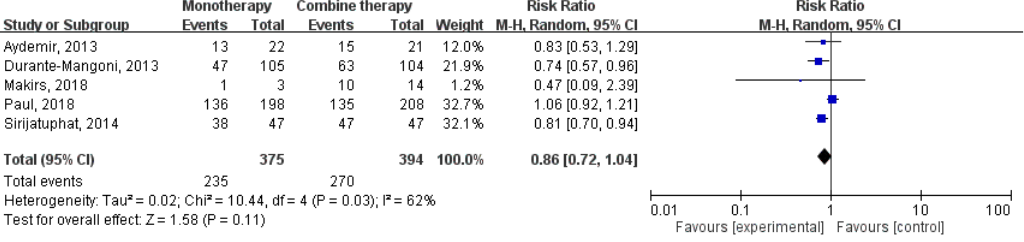
Figure 6. Colistin monotherapy versus colistin-based combination therapy, microbiologic response. M-H, Mantel-Haenszel.